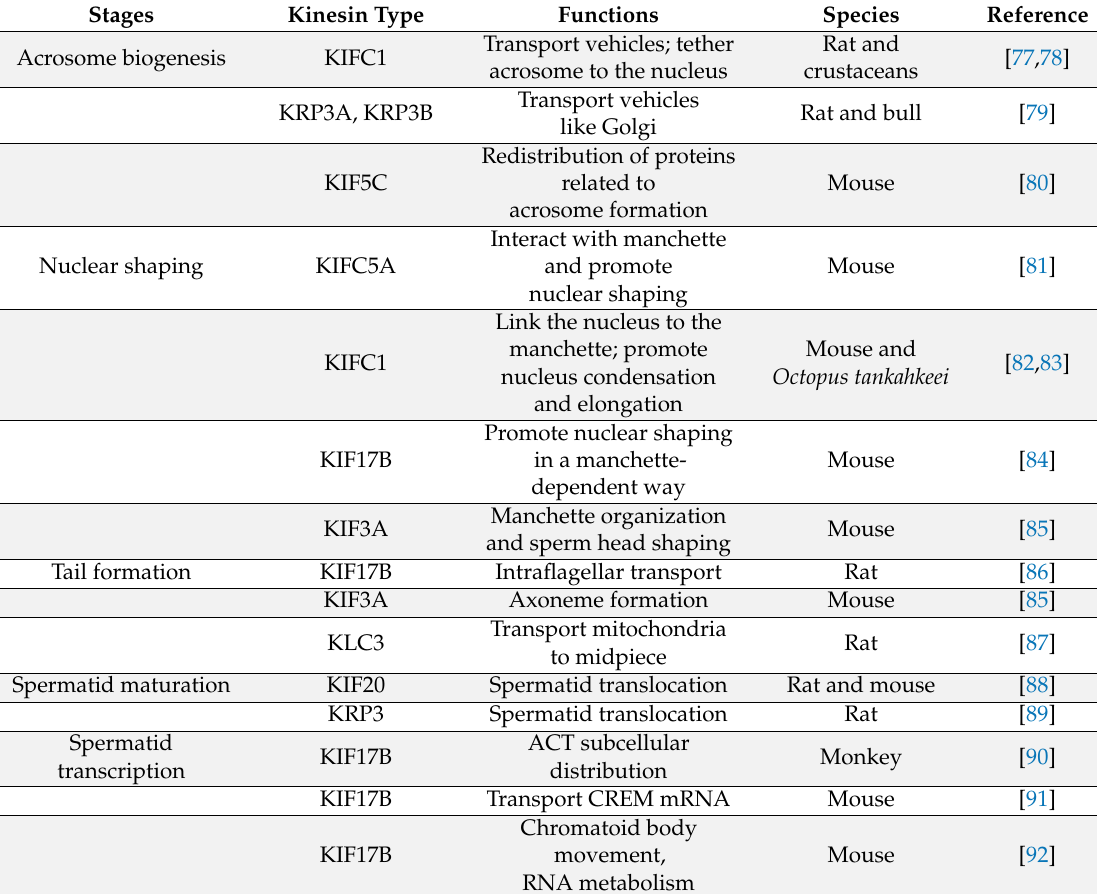
Table 2. Kinesins playing a role during sperm di ff